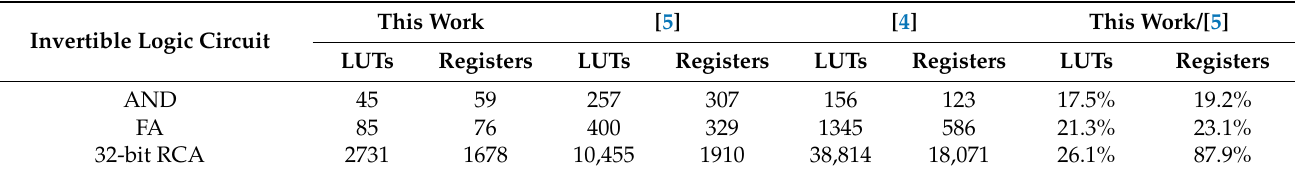
Table 3. FPGA resource utilization of the invertible logic